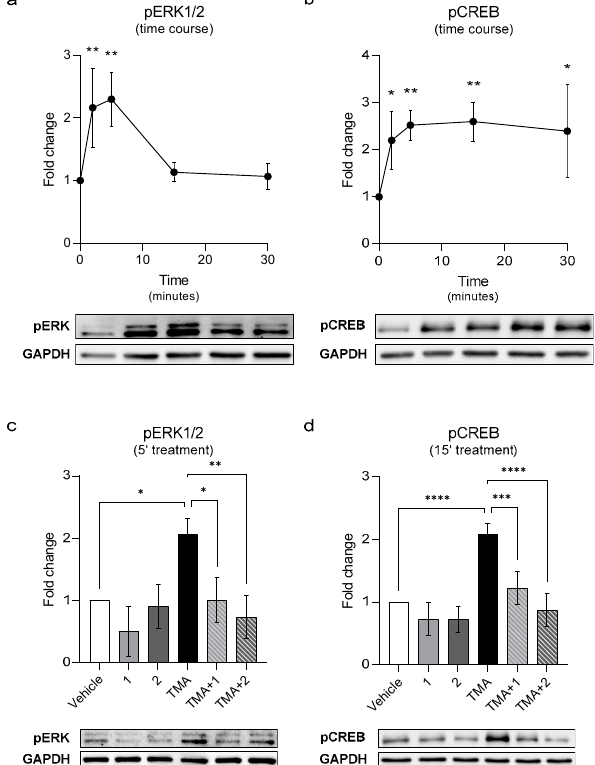
Figure 4. Evaluation of the antagonistic activity on ERK and CREB phosphorylation. HEK293 cells transfected with rho-TAAR5 were treated with TMA at 10 µ M and lysed at different time points to assess ERK ( a ) and CREB ( b ) phosphorylation. After evaluating the best time point at which TMA induced an increase in pERK and pCREB, cells were treated with active compounds at 10 µ M individually or in a set with TMA ( c , d ). Data represent means ± SEM. n = 3, 4 per group. * p < 0.05; ** p < 0.01; *** p < 0.001; **** p < 0.0001. One-way ANOVA followed by Dunnet’s multiple comparison